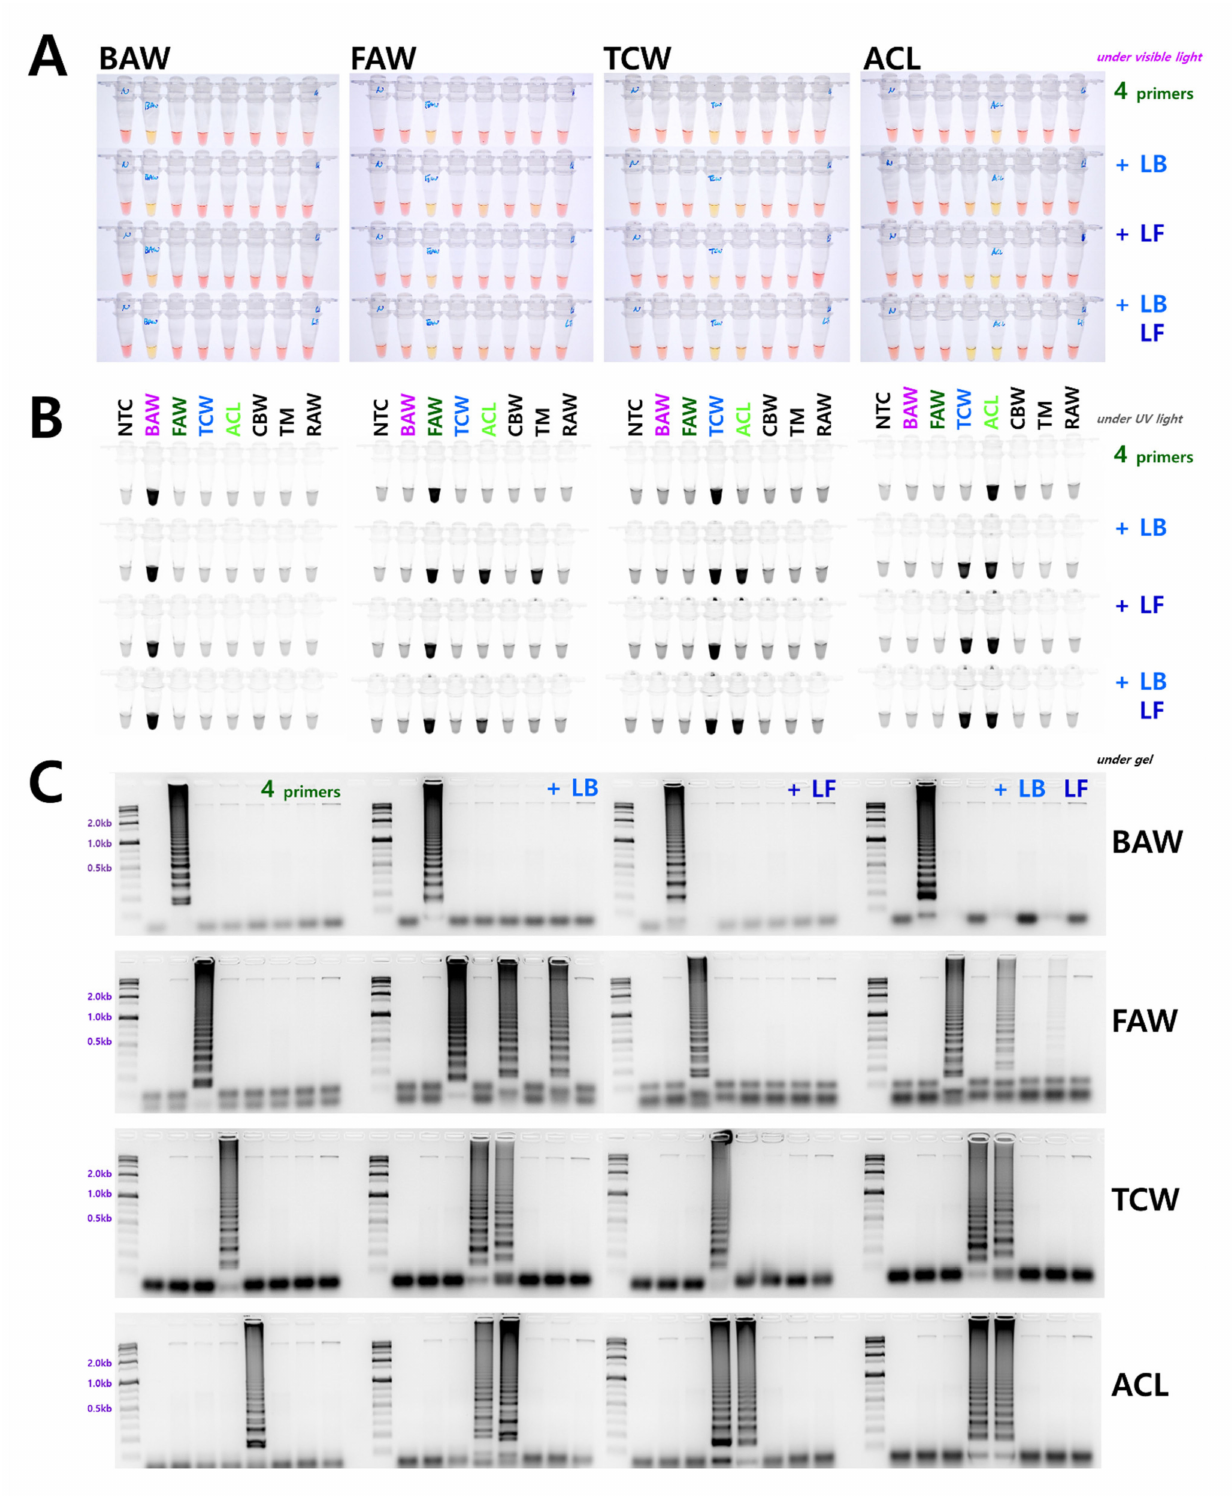
Figure 2. LAMP assay results with four primers (F3, B3, FIP, and BIP) and additional loop primers, loop backward (LB) and loop forward (LF). The LAMP assay was performed at an incubation temperature of 61 ◦ C for 60 min under ( A ) visible light, ( B ) ultraviolet light with SYBR, and ( C ) gel electrophoresis. NTC: no template control, BAW: Beet armyworm, S. exigua , FAW: Fall armyworm, S. frugiperda , TCW: Tobacco cutworm, S. litura , ACL: African cotton leafworm S. littoralis , CBW: Cotton bollworm, Helicoverpa armigera , TM: Turnip moth, Agrotis segetum , RAW: Rice armyworm, Mythimna loreyi